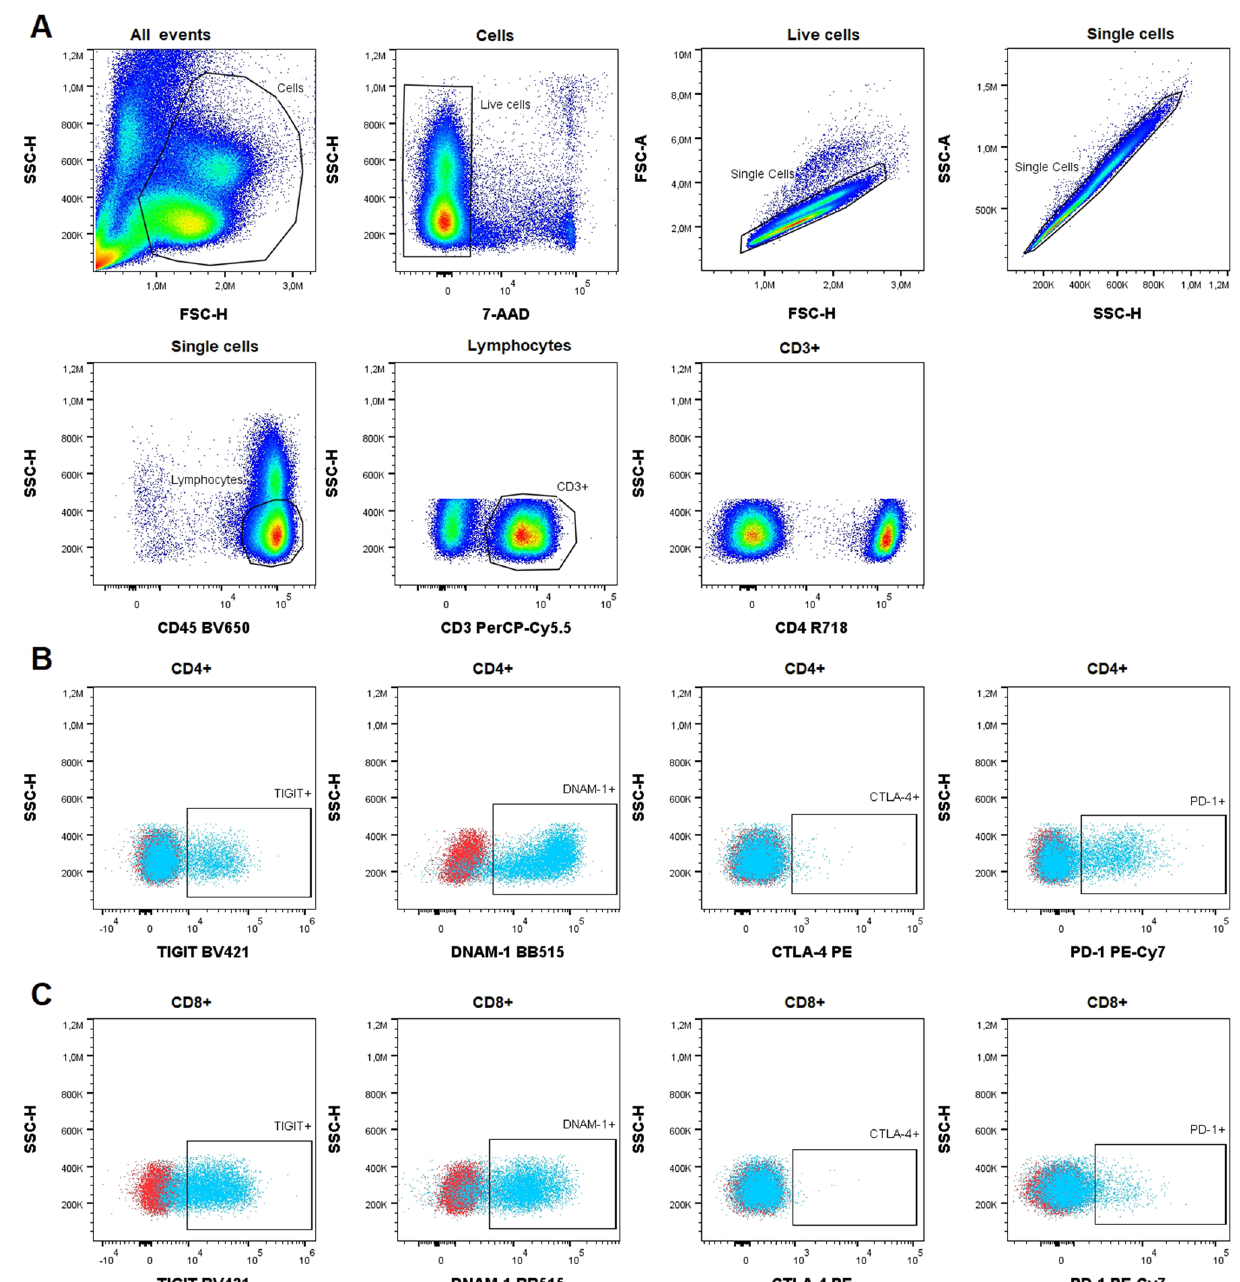
Fig. 1 Gating strategy applied in the study shown in a representative MM patient sample. A In the first panel, the cell subset was defined among all events acquired in a forward scatter (FSC)–height ( H )/ Side scatter (SSC)–height ( H ) plot. Next, within this cell subset, live cells (7-AAD − ) were selected for further analyses. In the following two panels, doublet discrimination was performed; First based on FSC-H and FSC-area ( A ), and second based on SSC–H and SSC- area ( A ). Subsequently, in order to identify the lymphocytes, defined as CD45 high SSC low , the live single cells were shown in a CD45/SSC